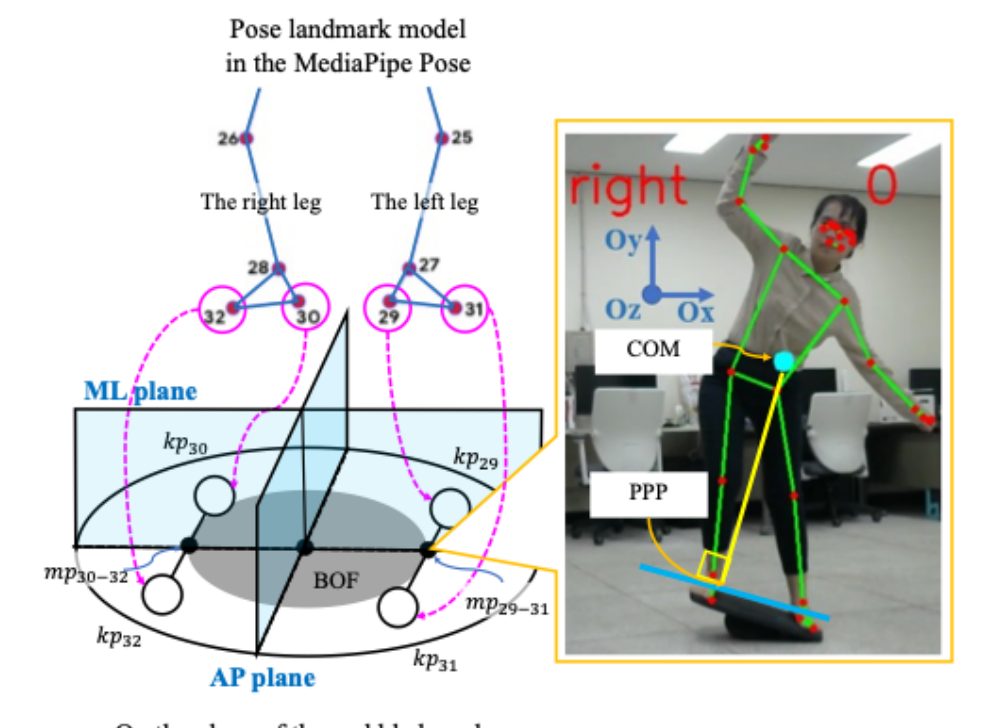
Figure 4. A description of boundary conditions based on the location of the perpendicular-projection point (PPP), and the state of human balance on the wobble board under the boundary